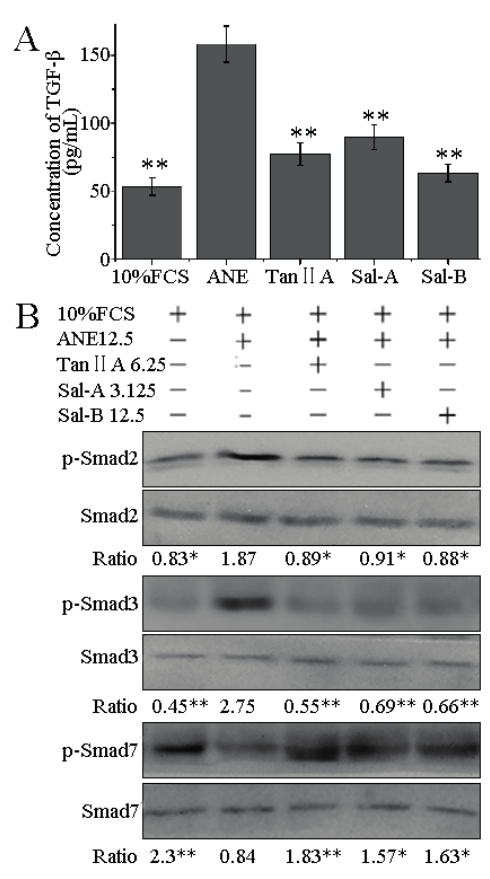
Figure 6. Effect of Tan-IIA, Sal-A and Sal-B on the ANE-induced release of TGF- β and activation of TGF- β /Smads pathway. HaCaT cells were exposed to ANE (12.5 μ g/mL), with or without Tan-IIA (6.25 μ M), Sal-A (3.125 μ M) and Sal-B (12.5 μ M) for 48 h. The supernatants and cells were collected and used in ELISA ( A ) and Western blot assays ( B ), respectively. n = 3, * p < 0.05 and ** p < 0.01 vs. the FCS + ANE